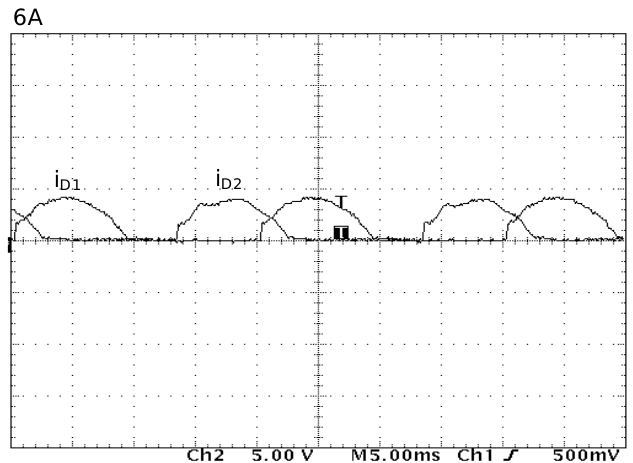
Figure 24. Current waveforms of selected diodes D1 and D2.